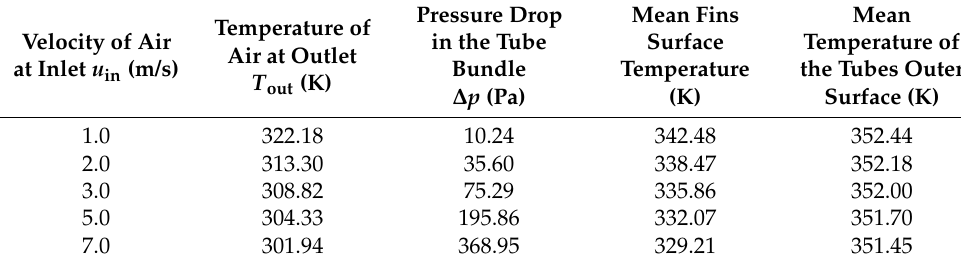
Table 5. Output data for the trimming diameter of 34 mm.